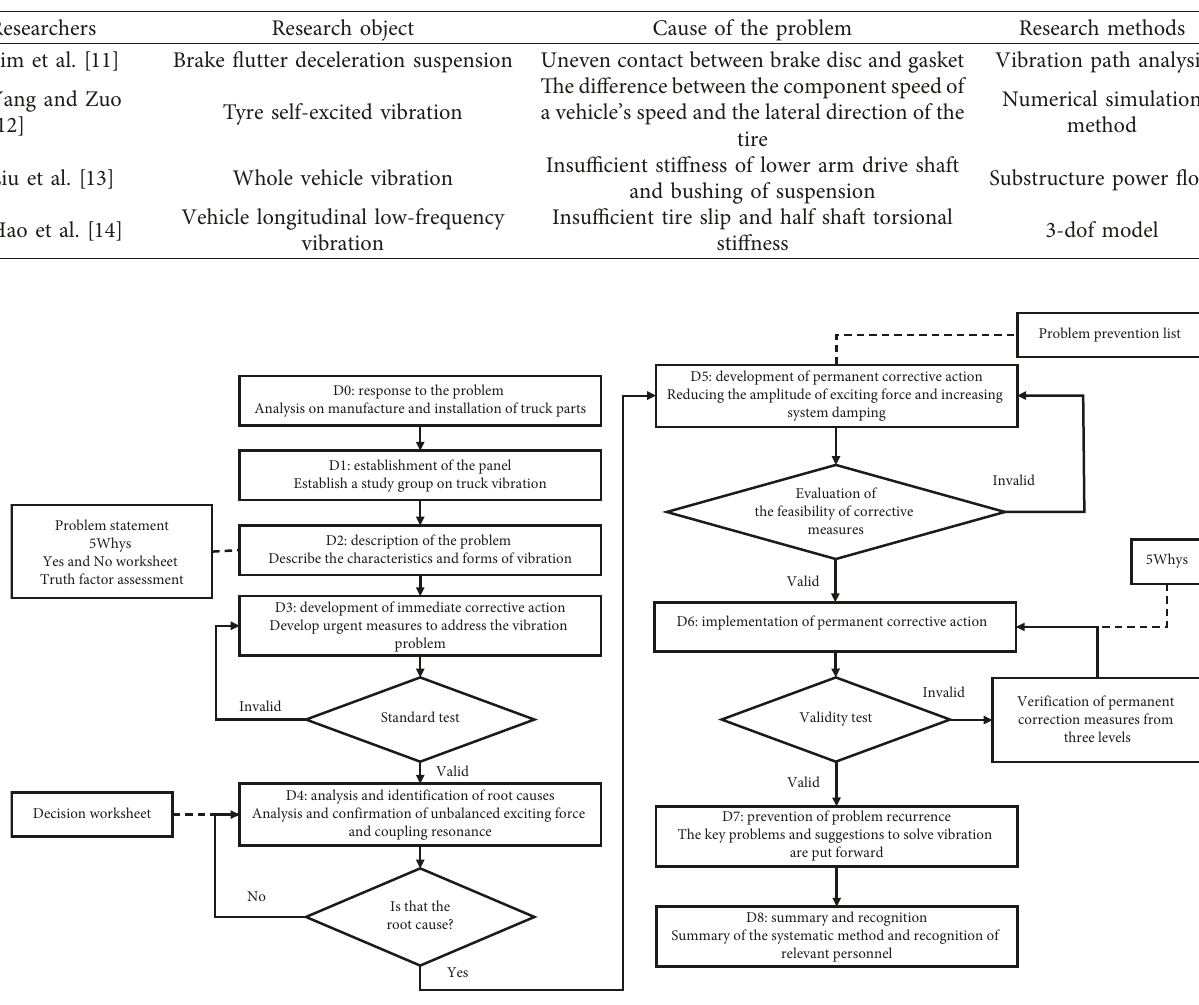
Figure 1: Improved model of G8D in systematically solving the problem of truck vibration. Table 2: Problem statement